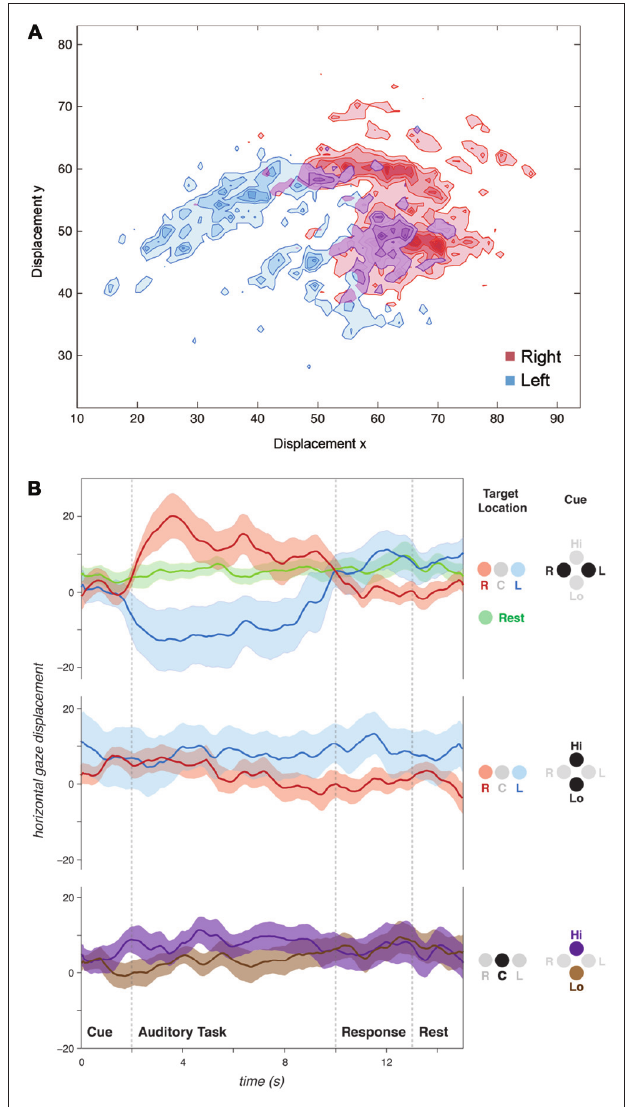
FIGURE 2 | Auditory spatial attention influences natural gaze position. (A) Plot of gaze position for a single subject over all spatially cued (“Listen-Left” or “Listen-Right”) trials. Displacement axes: y = vertical, x = horizontal. (B) Horizontal gaze position for all subjects grouped by cue and target sound location. Spatial cues influenced gaze position during the subsequent listening task. No gaze biases were observed for spectral discriminations (“Listen-High” or “Listen-Low”) regardless of whether stimuli were presented dichotically (“R” and “L”) or diotically (“C”). Positive values on y-axis represent rightward, and negative values represent leftward gaze displacements. Displacement axes are in arbitrary units.